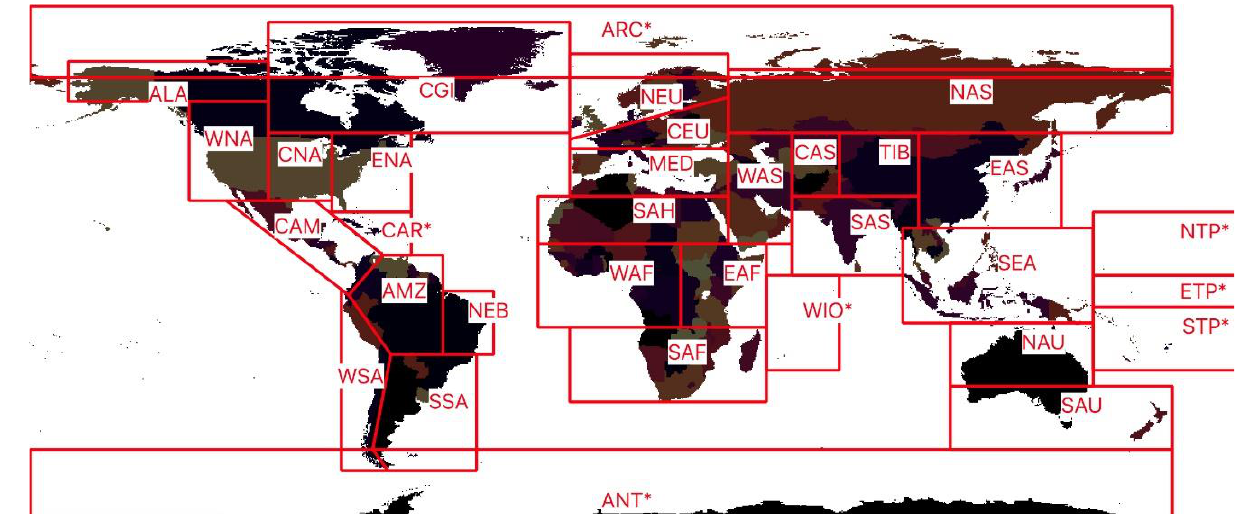
Figure 4. Map of climate macro regions of the world. Table 1. Land use types, possible drought impacts, and droughts